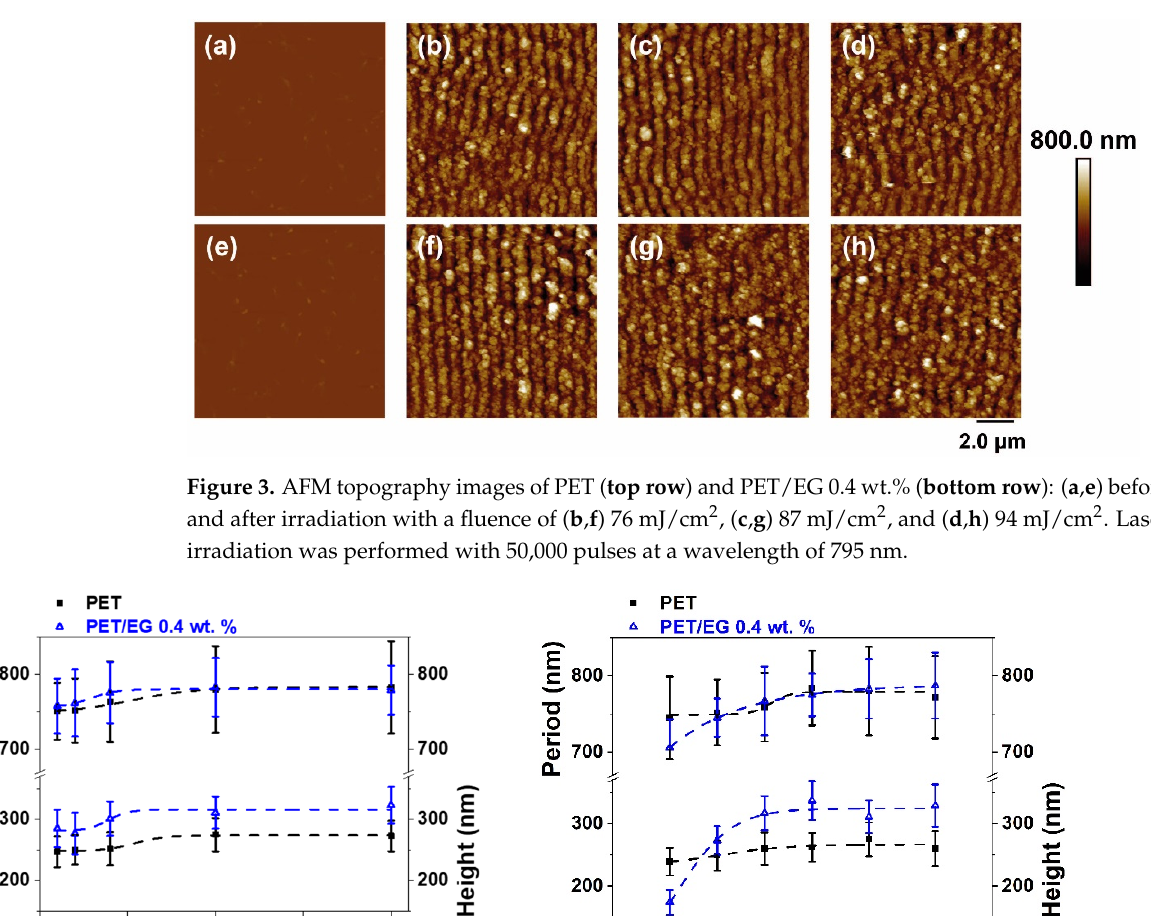
Figure 3. AFM topography images of PET ( top row ) and PET/EG 0.4 wt.% ( bottom row ): ( a , e ) before and after irradiation with a fluence of ( b , f ) 76 mJ/cm 2 , ( c , g ) 87 mJ/cm 2 , and ( d , h ) 94 mJ/cm 2 . Laser irradiation was performed with 50,000 pulses at a wavelength of 795 nm.